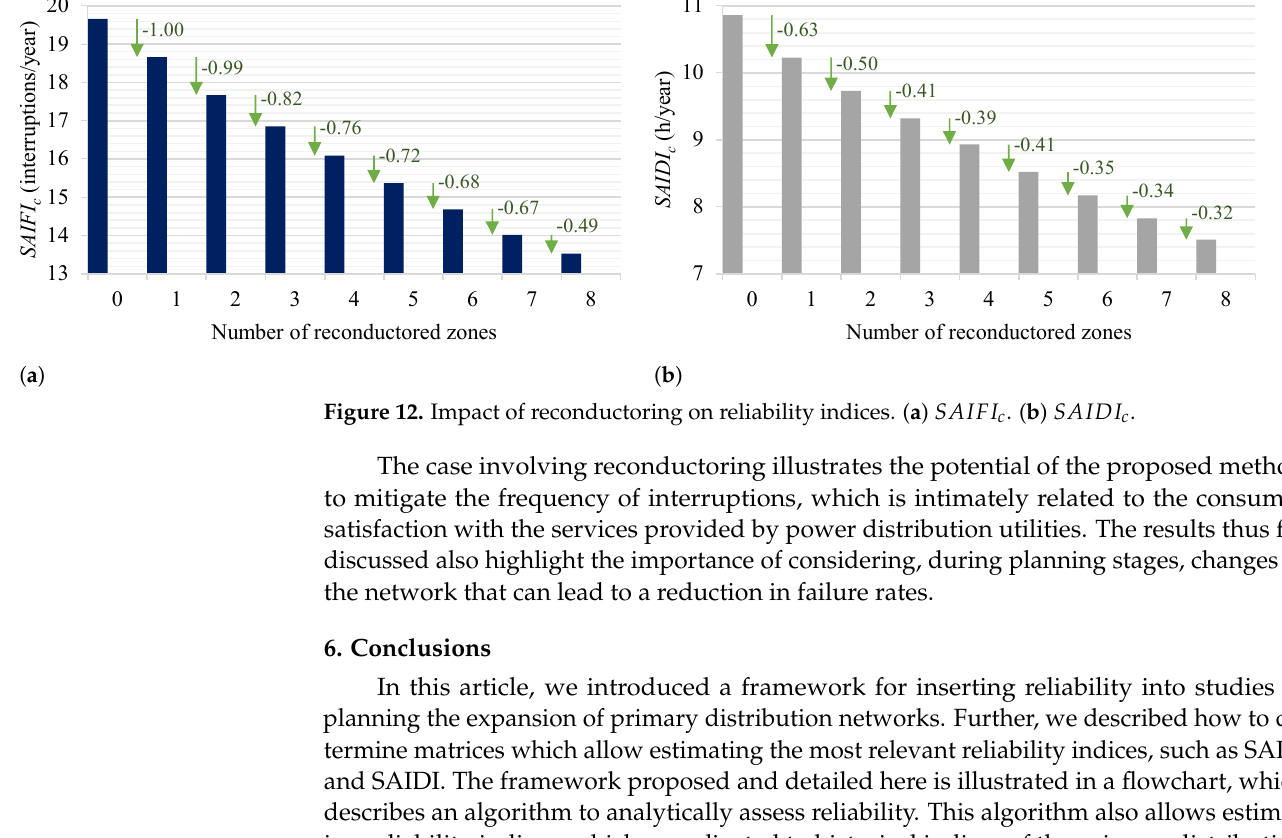
Figure 11. Impact of sectionalizing switches automation on reliability indices. ( a ) SAIDI c . ( b ) EENS c . To assess the impact of reconductoring with covered conductors on SAIFI c , SAIDI c , and EENS c , we consider here the reconductoring of zones of the network. Initially, zone 4 was reconductored, given that it has the highest contribution of faults to the SAIFI c . Then, the two zones with the highest fault contribution to the SAIFI c were reconductored, and so on, successively, up to ten zones with the highest values of fault contribution to the SAIFI c . Figure 12a,b, respectively, show SAIFI c and SAIDI c versus the number of reconductored zones. When no reconductoring occurs, no changes will take place in the network. When the reconductoring occurs inside zone 4, we obtain EENS c = 30.43 MWh/year, which represents a reduction of 1.88 MWh/year, while with the reconductoring of eight zones, we obtain EENS c = 22.32 MWh/year, thus a reduction of 9.99 MWh/year.